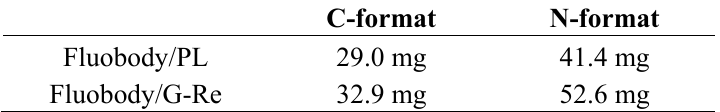
Table 1. The yields of fluobodies after purification by immobilized metal ion affinity chromatography.